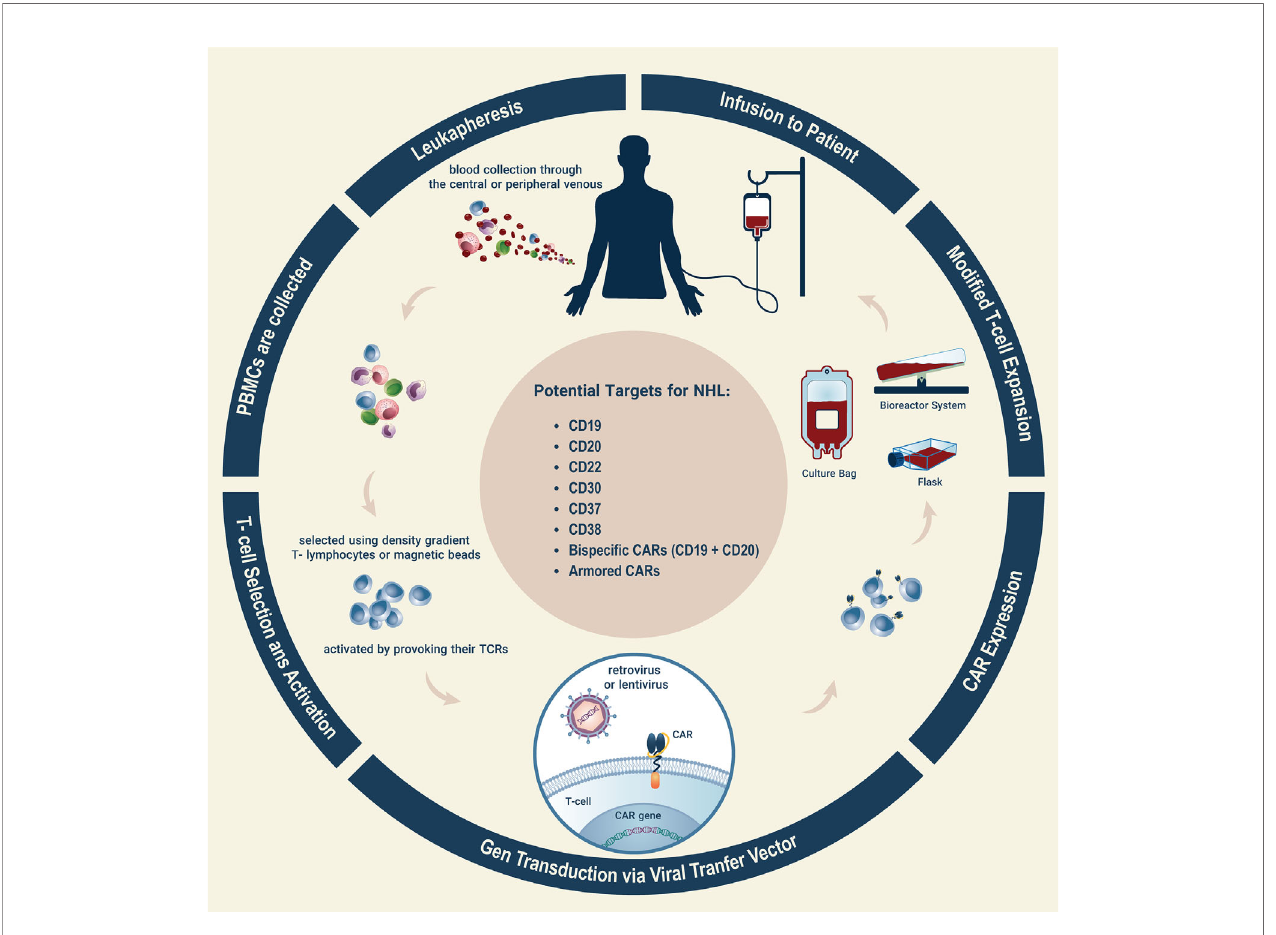
FIGURE 1 | Characteristic of CAR-T cells and their isolation, engineering, transfection, and expansion in patients with NHL. The fi rst stage of CAR-T cell engineering is leukapheresis in which leukocytes are collected through central or peripheral venous (Stage 1). Then, PBMCs are puri fi ed among collected leukocytes (Stage 2). Next, density gradient or magnetic beads are used to purify T cells among collected PBMCs. Also, T cells get activated by provoking their TCRs (Stage 3). Viral transfection methods using viral vectors such as retrovirus or lentivirus are the next steps (Stage 4). The next step is done ex-vivo in which the cells are directed to be expanded (stage 5). In the last stage, modi fi ed CAR-T cells are expanded by culturing or bioreactor system and were injected into the same patients (step 6). Various antigens used as CAR-T cells ’ targets in NHL have been shown. CAR, chimeric antigen receptor; PBMC, peripheral blood mononuclear cell; TCR, T-cell